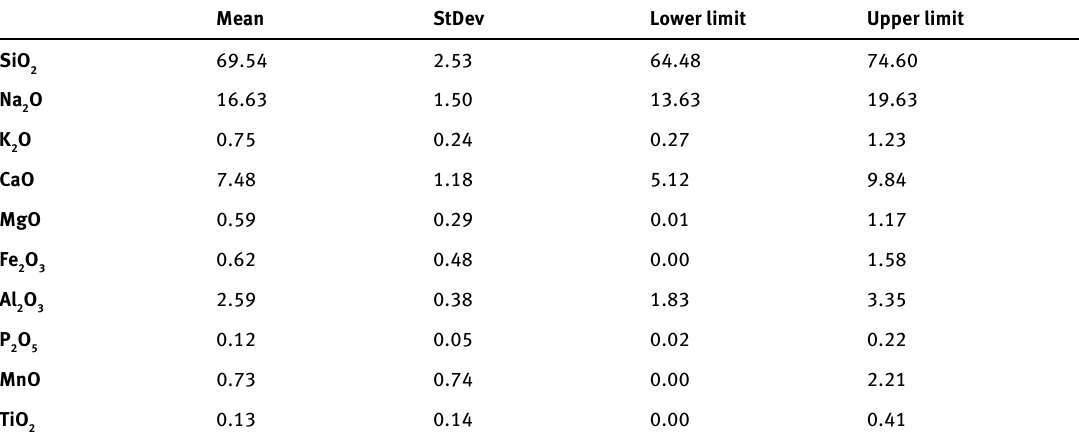
Table 1: Average values and compositional intervals of the major elements (in wt%) in the Roman glass of the first millennium AD, produced in the eastern and western part of the Roman Empire. From Degryse (2014).